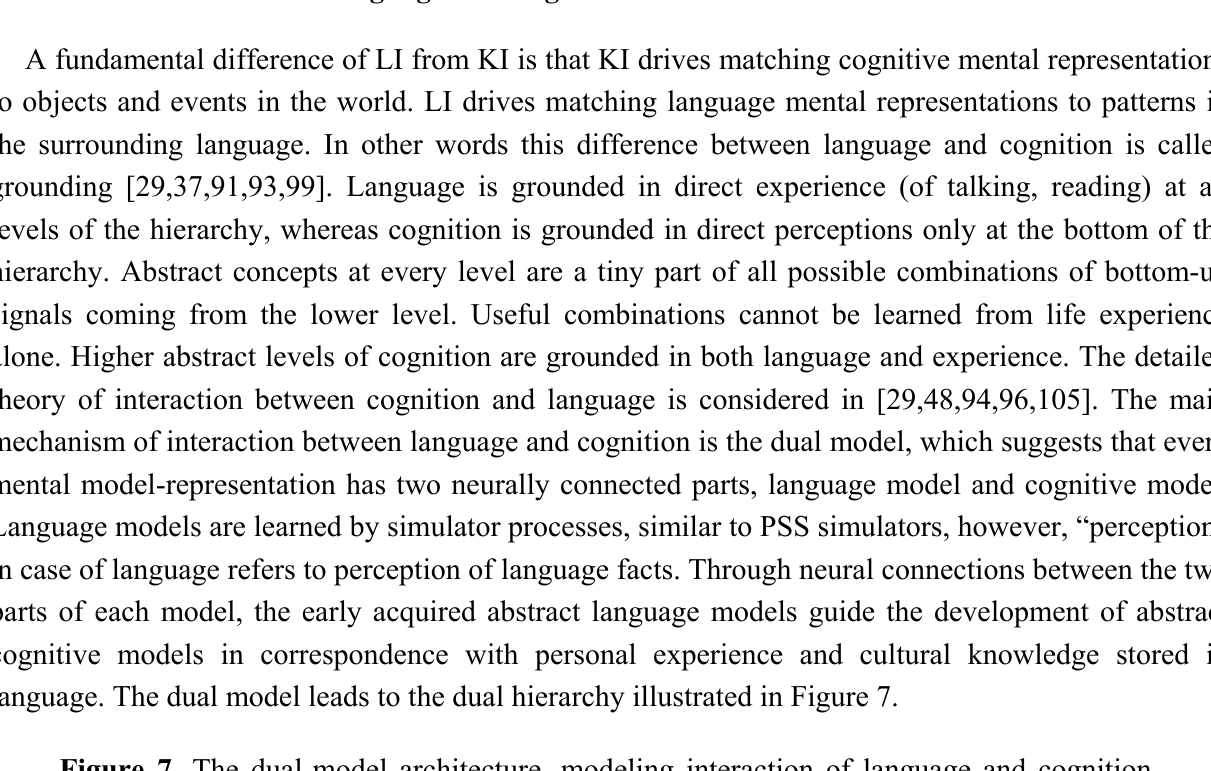
Figure 7. The dual-model architecture, modeling interaction of language and